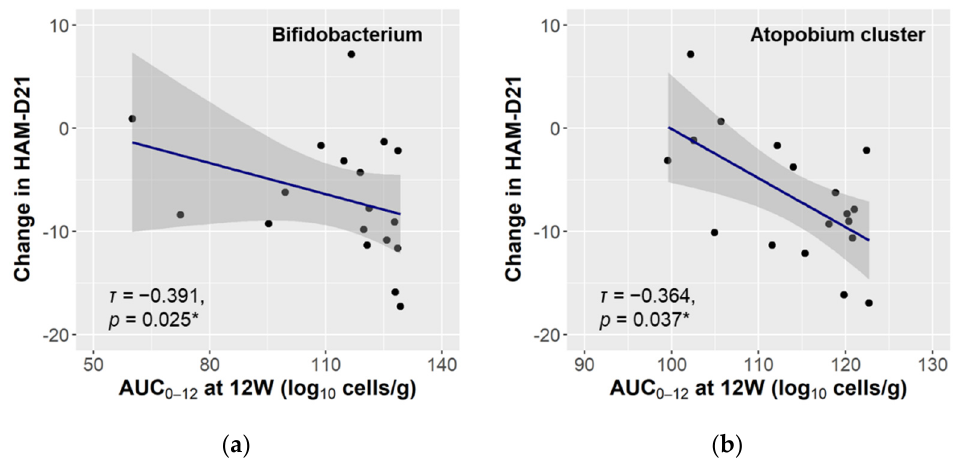
Figure 3. Correlation between the gut microbiota and change in the severity of depressive symptoms. The 12-week AUCs of the bacterial counts of Bifidobacterium ( a ) and the Atopobium cluster ( b ) were calculated, and their statistical association with the change in the HAM-D21 score over the same period was evaluated ( n = 18). The linear regression curve with 95% CI is plotted (grey area), and Kendall’s rank correlation coefficient ( τ ) and p -value (* p < 0.050) are shown.